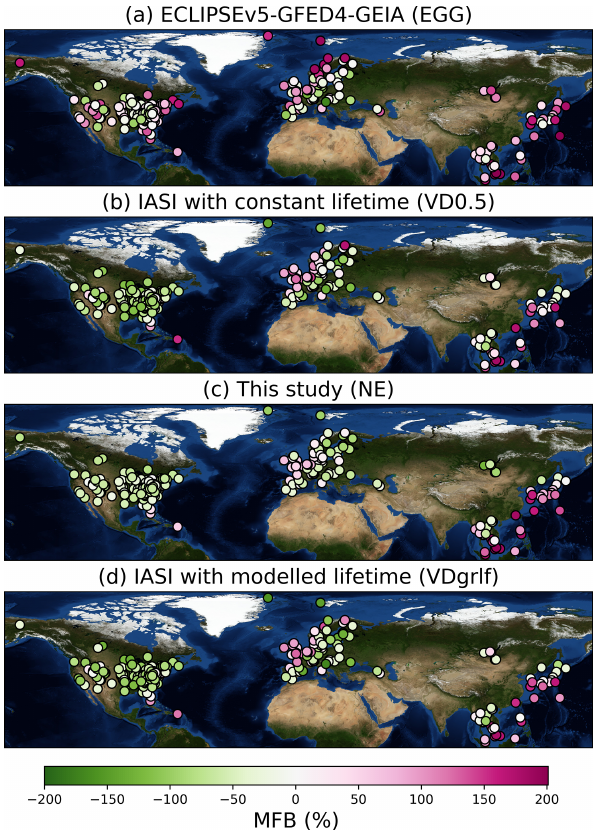
Figure 8. Overview of the comparison with ground-based measure- ments of ammonia. MFB for each of the stations from AMoN, EMEP and EANET monitoring stations calculated after running LMDz-OR-INCA with the emissions of EGG, VD0.5, NE and VD- grlf for the period